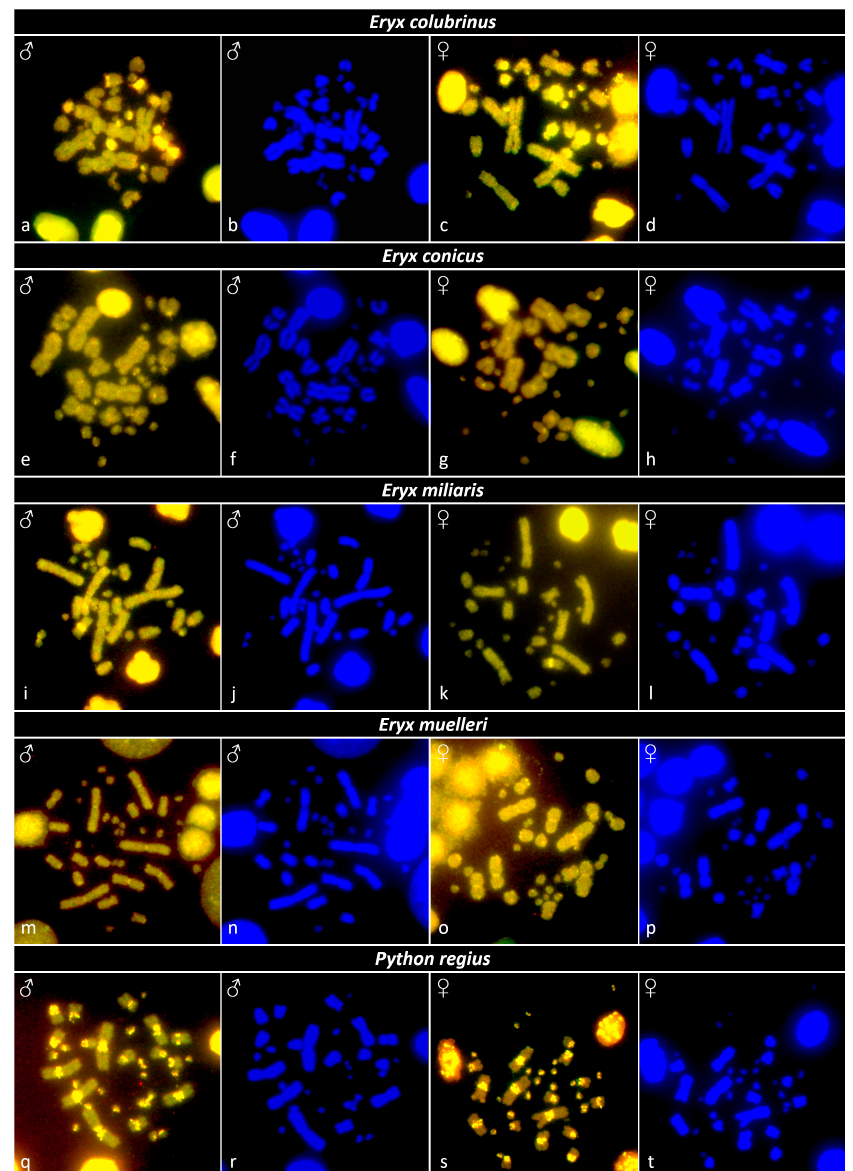
Figure 5. Comparative genome hybridization in metaphases for the species: ( a – d ) Eryx colubrinus , ( e – h ) Eryx conicus , ( i – l ) Eryx miliaris , ( m – p ) Eryx muelleri , and ( q – t ) Python regius . Sex-specific regions were not identified in any of the studied specimens. For each metaphase, we present an image of the merged signal from the hybridization of the green (male-specific) and red (female-specific) probe and a photo with DAPI stain to better visualize the chromosome morphology. Sex is indicated.